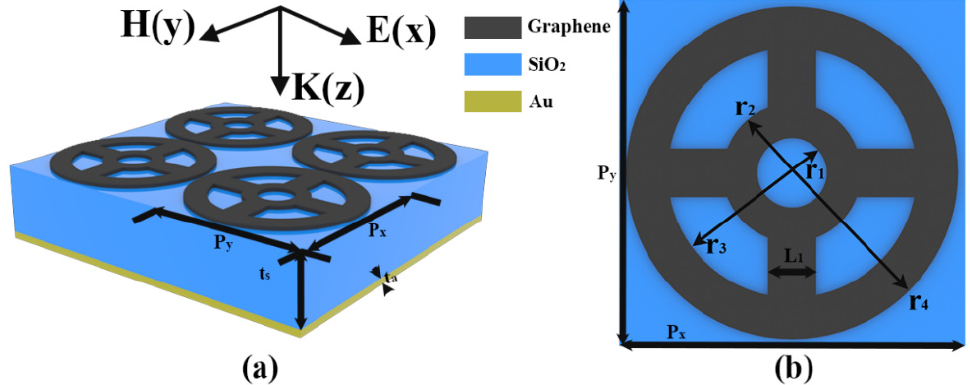
Figure 1. ( a ) Three-dimensional view of the ultra-narrowband graphene SPR absorber array ( b ) Platform of the absorber.